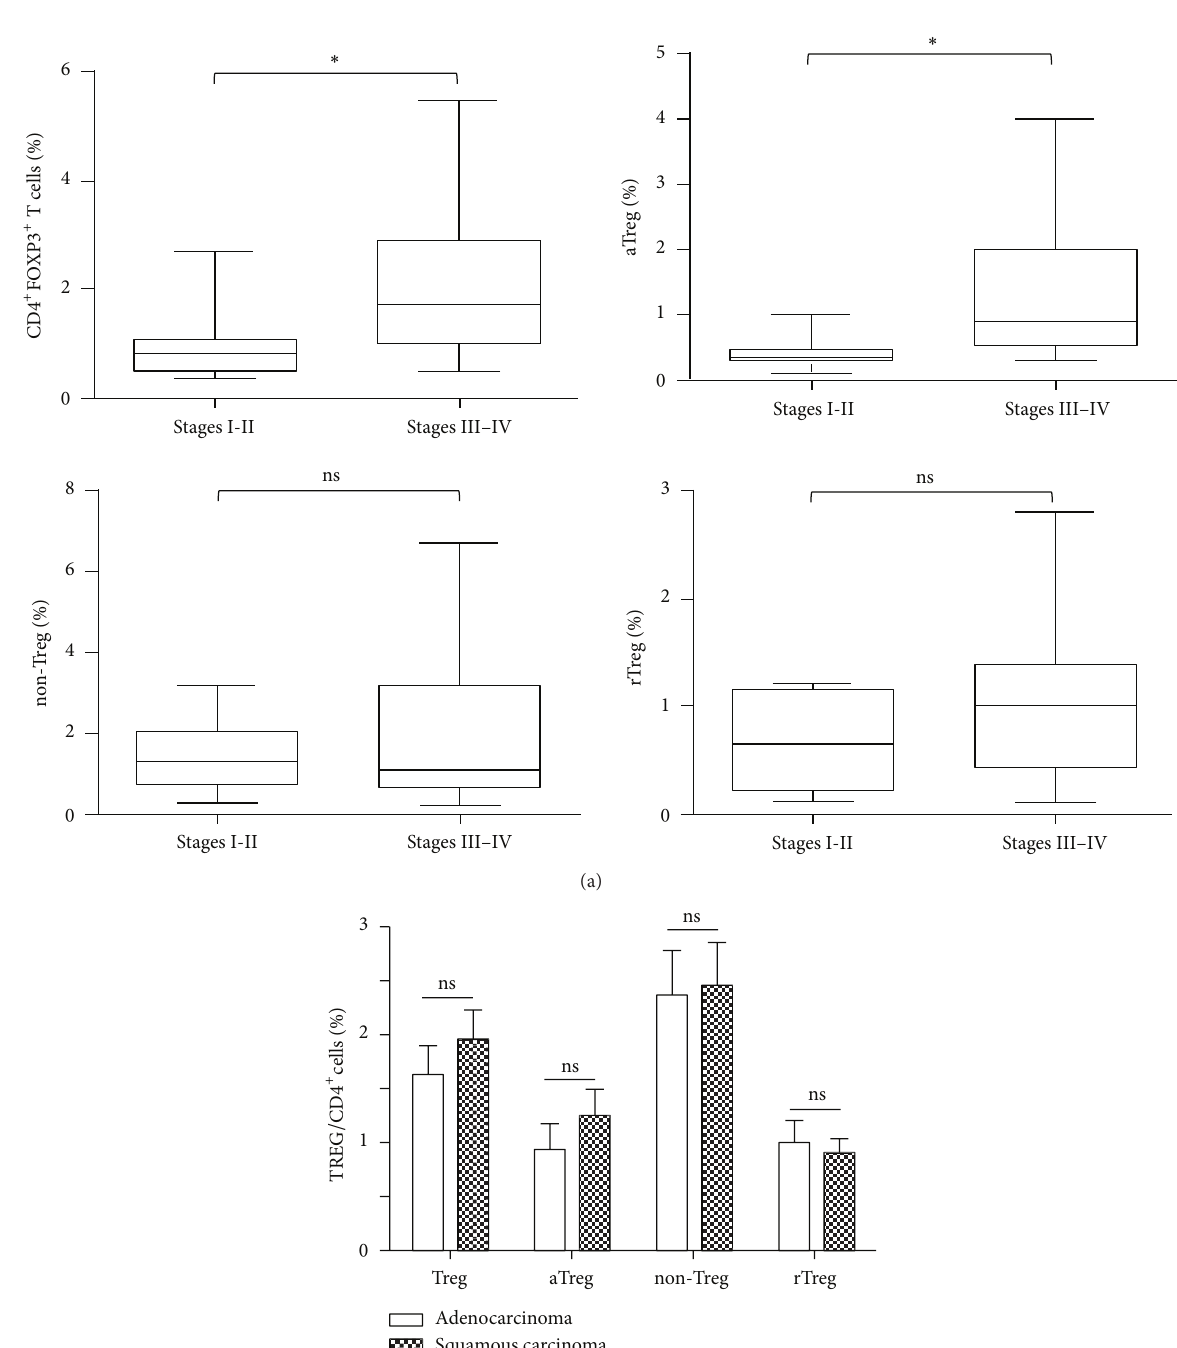
Figure 3: aTreg cells had a higher level in patients with advanced NSCLC. NSCLC patients were grouped according to clinical stage and pathology. (a) The percentages of CD4 + Foxp3 + T cells, aTreg cells, non-Treg cells, and rTreg cells were compared in PBMCs of NSCLC patients at stages I-II and III-IV. (b) The 4 groups of Treg cells were compared in PBMCs of NSCLC patients between adenocarcinoma and squamous carcinoma. Statistical analysis was determined by one-way ANOVA. ∗ 𝑃 < 0.05